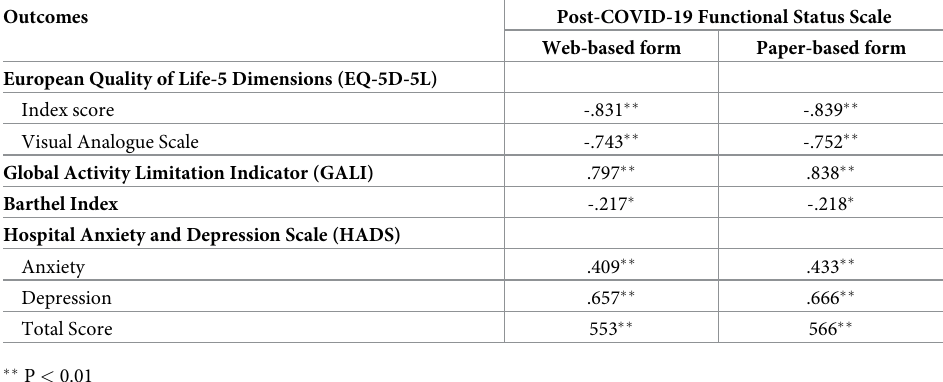
Table 2. Spearman correlations between functional status and quality of life, limitations in activities of daily liv- ing and psychological